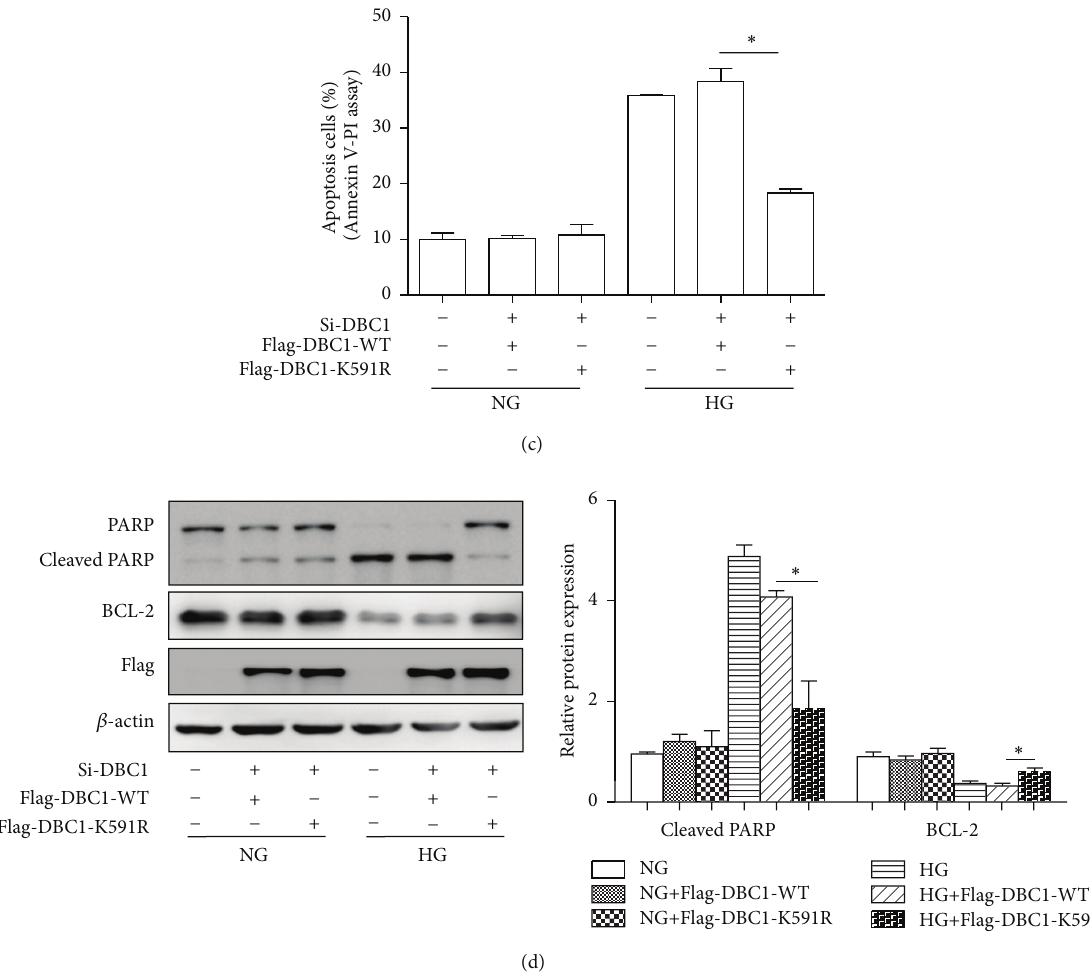
Figure 6: Sumoylation of DBC1 contributed to SENP1-mediated apoptosis under high glucose conditions. (a) After HEK293T cells were transfected with Flag-DBC1-WT or Flag-DBC1-K591R, with or without RH-SUMO3 as indicated for 48h, cell lysates were subjected to immunoprecipitation with anti-Flag antibody followed by immunoblot analysis. (b) Effect of siRNA-mediated knockdown on DBC1 expression in BRPCs incubated in normal glucose. (c) Analysis of cellular apoptosis levels in the BRPC treatment groups for 48h: NG, NG+Flag-DBC1-WT, NG+Flag-DBC1-K591R, HG, HG+Flag-DBC1-WT, and HG+Flag-DBC1-K591R. (d) Cleaved PARP and BCL-2 protein expression profiles in the six groups. Data are presented as their means ± SEM. Bars indicate SDs. ∗ 𝑃 < 0.05 versus HG+Flag-DBC1